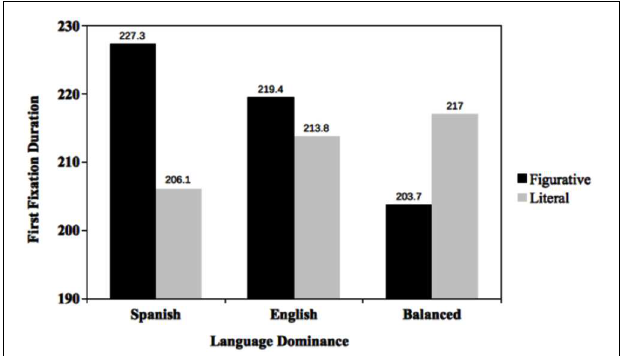
FIGURE 1 | First fixation duration for figurative- and literal-biased targets as a function of language